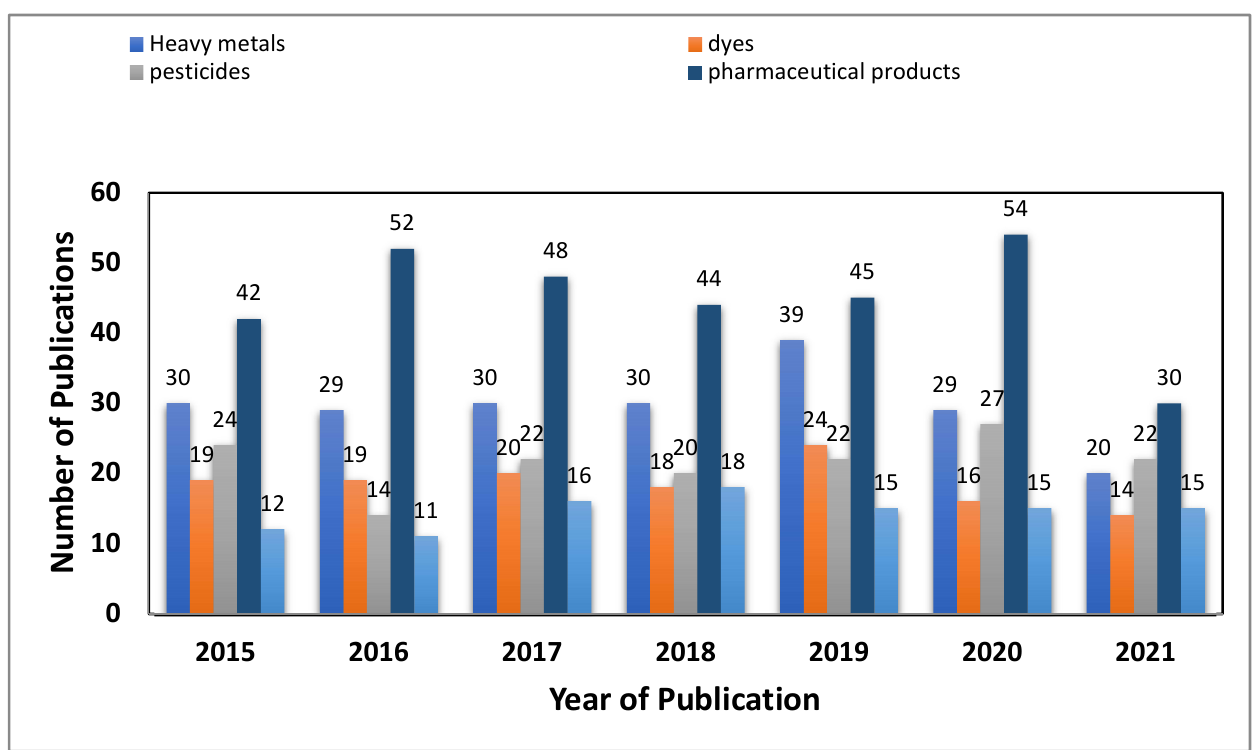
Figure 2. Number of molecularly imprinted polymers publications by writing “MIP” with “heavy metals”, “dyes”, “pesticides”, “pharmaceutical products” “bisphenols”, “phthalates”, and “personal care Products”, using PubMed on 15 September 2021 [29].